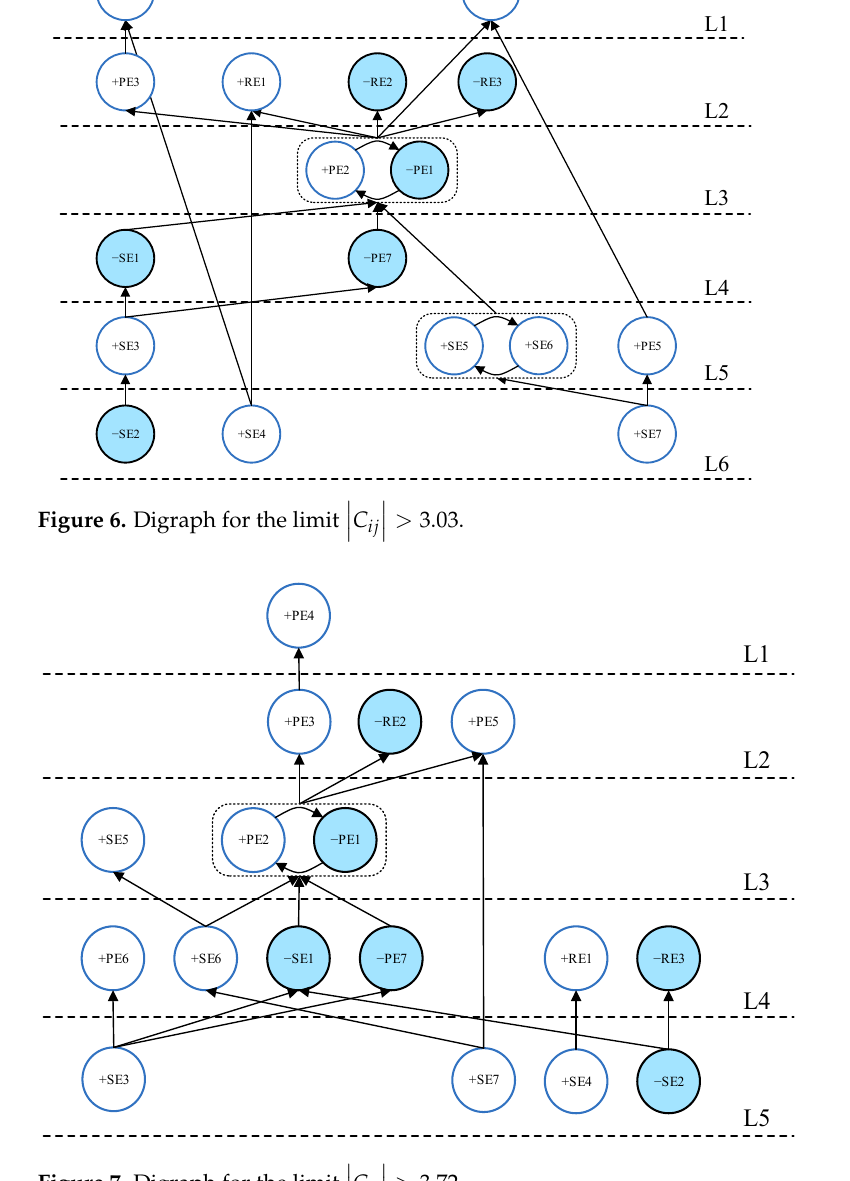
Figure 7. Digraph for the limit (cid:3627)𝐶 (cid:3036)(cid:3037) (cid:3627) > 3.72 .